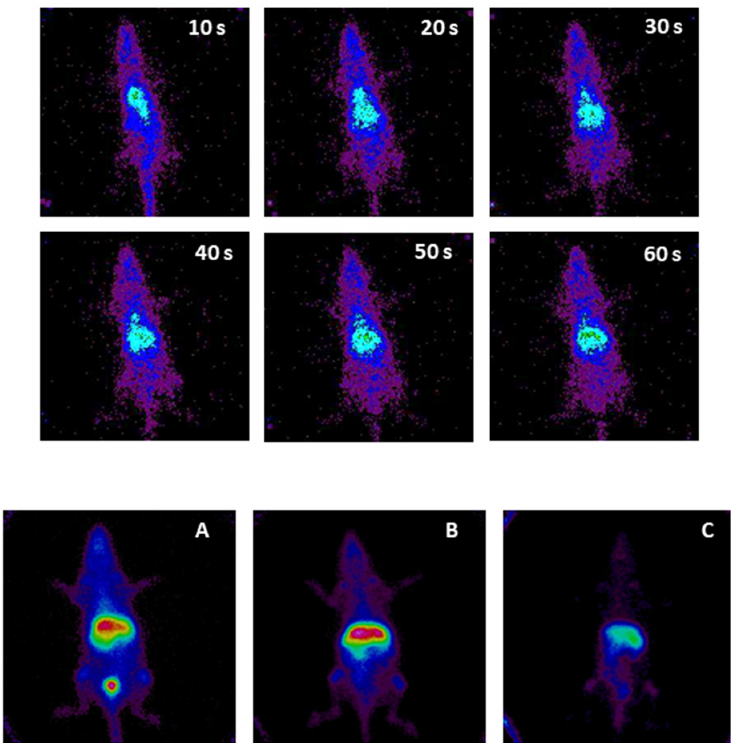
Figure 4. Radiolabeling and gamma camera: biodistribution of PF127 micelles during the first mi- nute after intravenous injection, as well as at 30 min ( A ), 3 h ( B ), and 24 h ( C ).